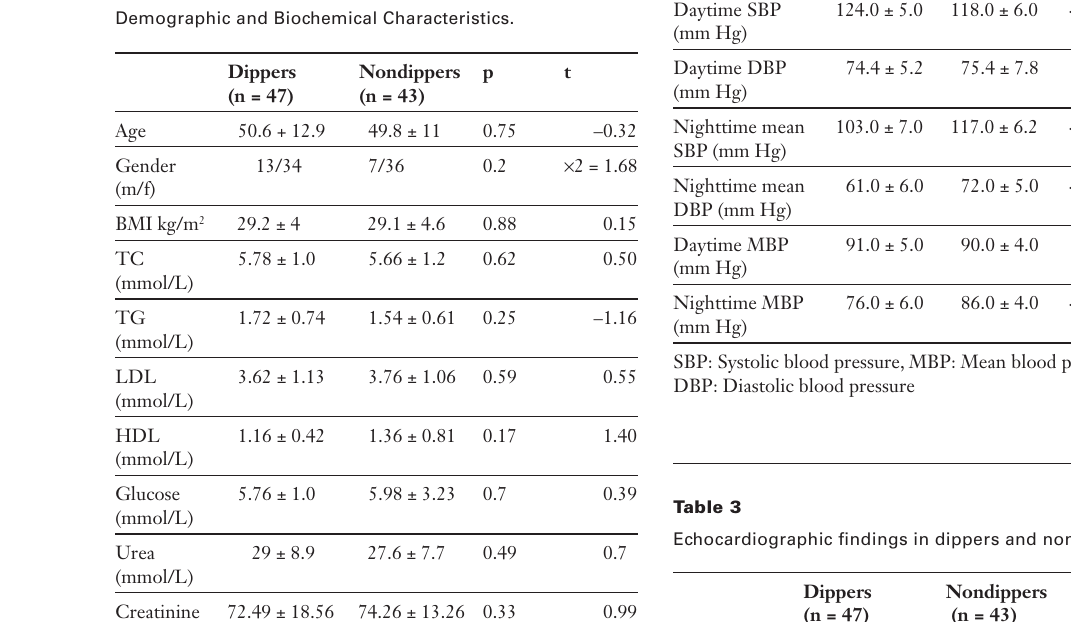
Demographic and Biochemical Characteristics.